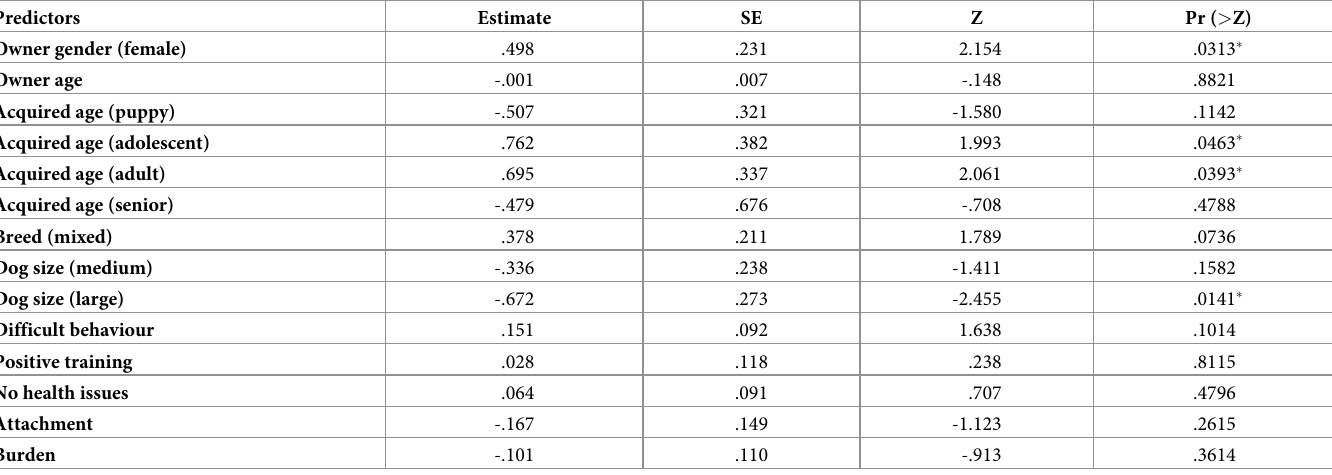
Table 19. Logistic regression of owner and dog parameters on non-Canadian origin